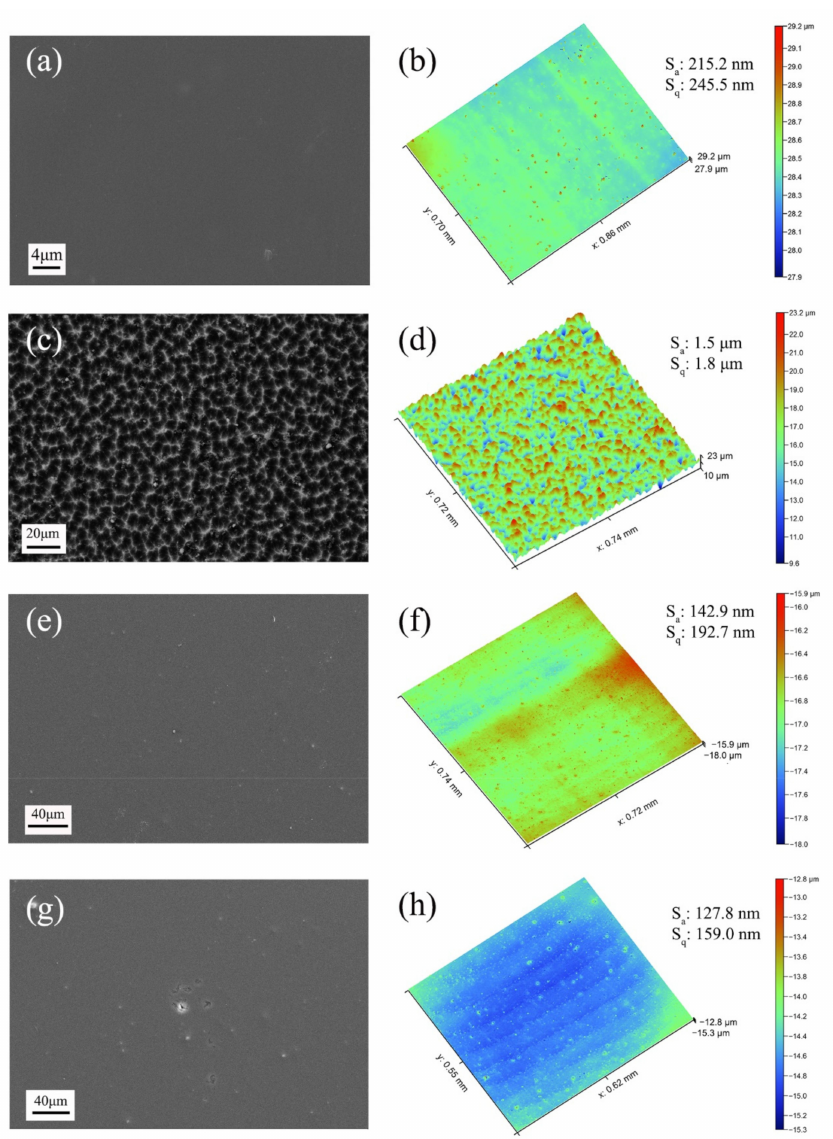
Figure 2. Surface morphologies of ( a ) Kapton, ( c ) Kapton after AO exposure, ( e ) as-prepared PHPS coating and ( g ) PHPS coating after AO exposure (Total fluence of AO exposure: 1.5 × 10 21 atoms cm − 2 ) and corresponding 3D morphologies of each sample were displayed aside in ( b , d , f , h ),